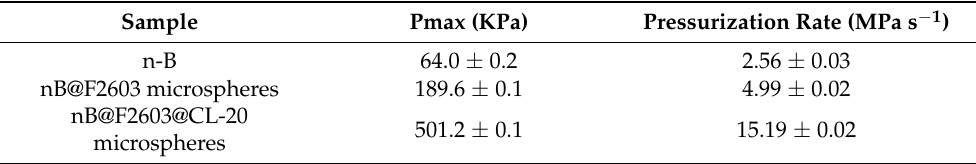
Figure 11. Pressure–time curves of n-B and nB@F2603 and nB@F2603@CL-20 microspheres under 1 MPa O 2 . Table 3. Maximum pressure (Pmax) and pressurization rate (dP/dt) of n-B and nB@F2603 and nB@F2603@CL-20 microspheres.